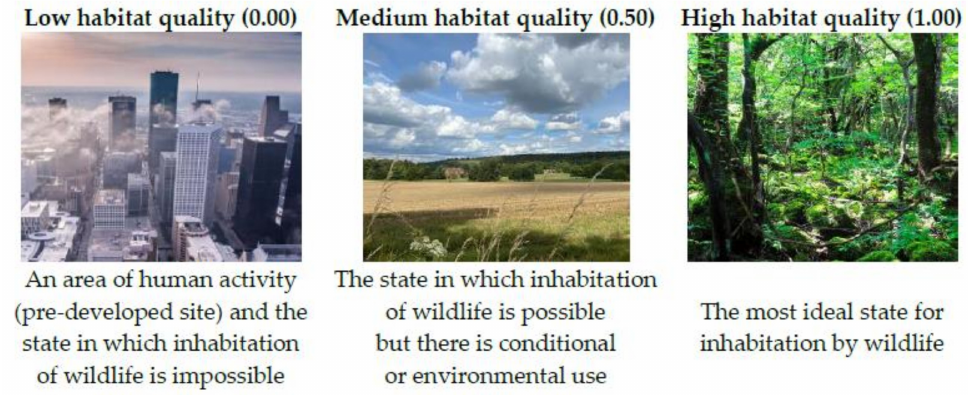
Figure 5. Examples of habitat quality